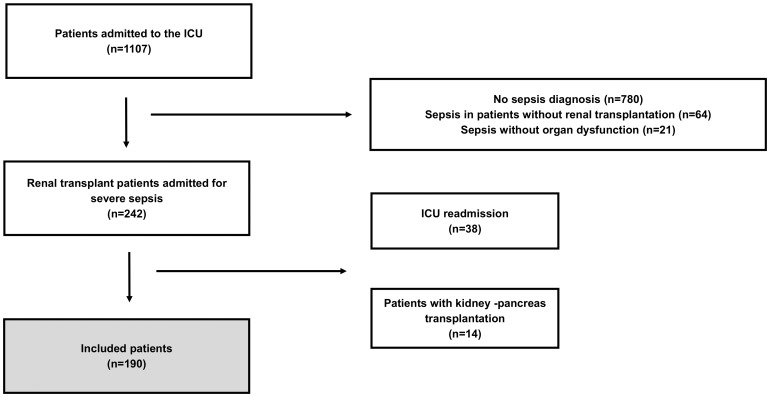
Study flowchart.ICU: intensive care unit.